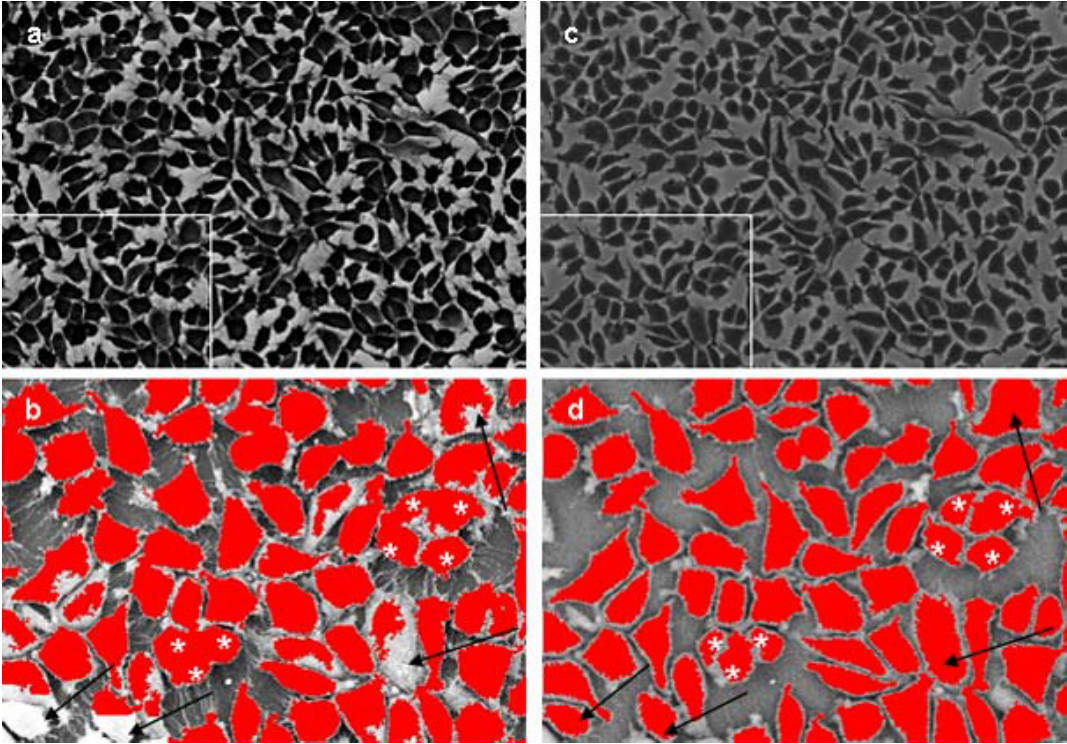
Figure 7. Automated image processing of SE- and BSE- images of the same preparation; (a) inverted original SE –image; (b) processed rectangle marked in (a) part of SE- image; (c) original BSE- image; (d) processed rectangle marked in (c) part of BSE-image. Note the recognition of whole cell area (d, arrows) and cell splitting (d, asterisks) in the BSE image in contrast to only a partial identification of cell area (b, arrows) and no cell splitting (b, asterisks) in SE.